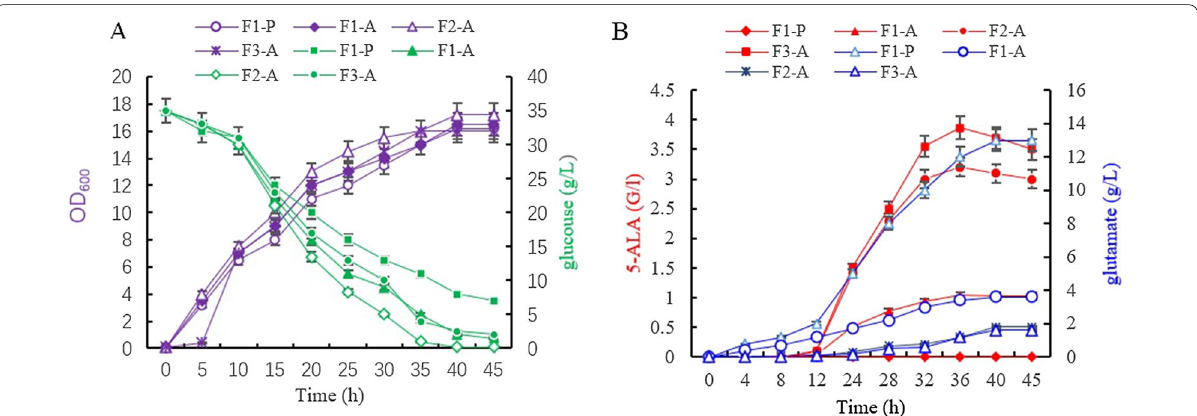
Fig. 2 The growth and glucose consumption ( A ), the accumulation of 5-ALA and glutamate ( B ) in C. glutamicum strainsF1-P, F1-A,